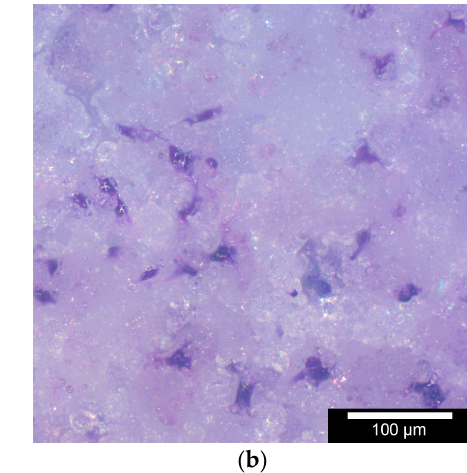
Figure A1. EDX Spectrum of the Nanocrystals (from top to bottom: BG, TCP, 50/50 and 70/30): Spectrum taken with FEI Quanta 250 FEG with Oxford EDX unit, at 10 kV, 100 Pa, 10 min livetime; BG: Ca/P ratio = 1.69 seems to be HA. TCP: Ca/P ratio = 1.70 seems to be HA; 50/50: Ca/P ratio = 1.72 seems to be HA; and 70/30: Ca/P ratio = 1.65 seems to be HA. The tiny structures of the Crystals in the background are shining, which is why Na, Mg, Al and Si were found in the spectra.